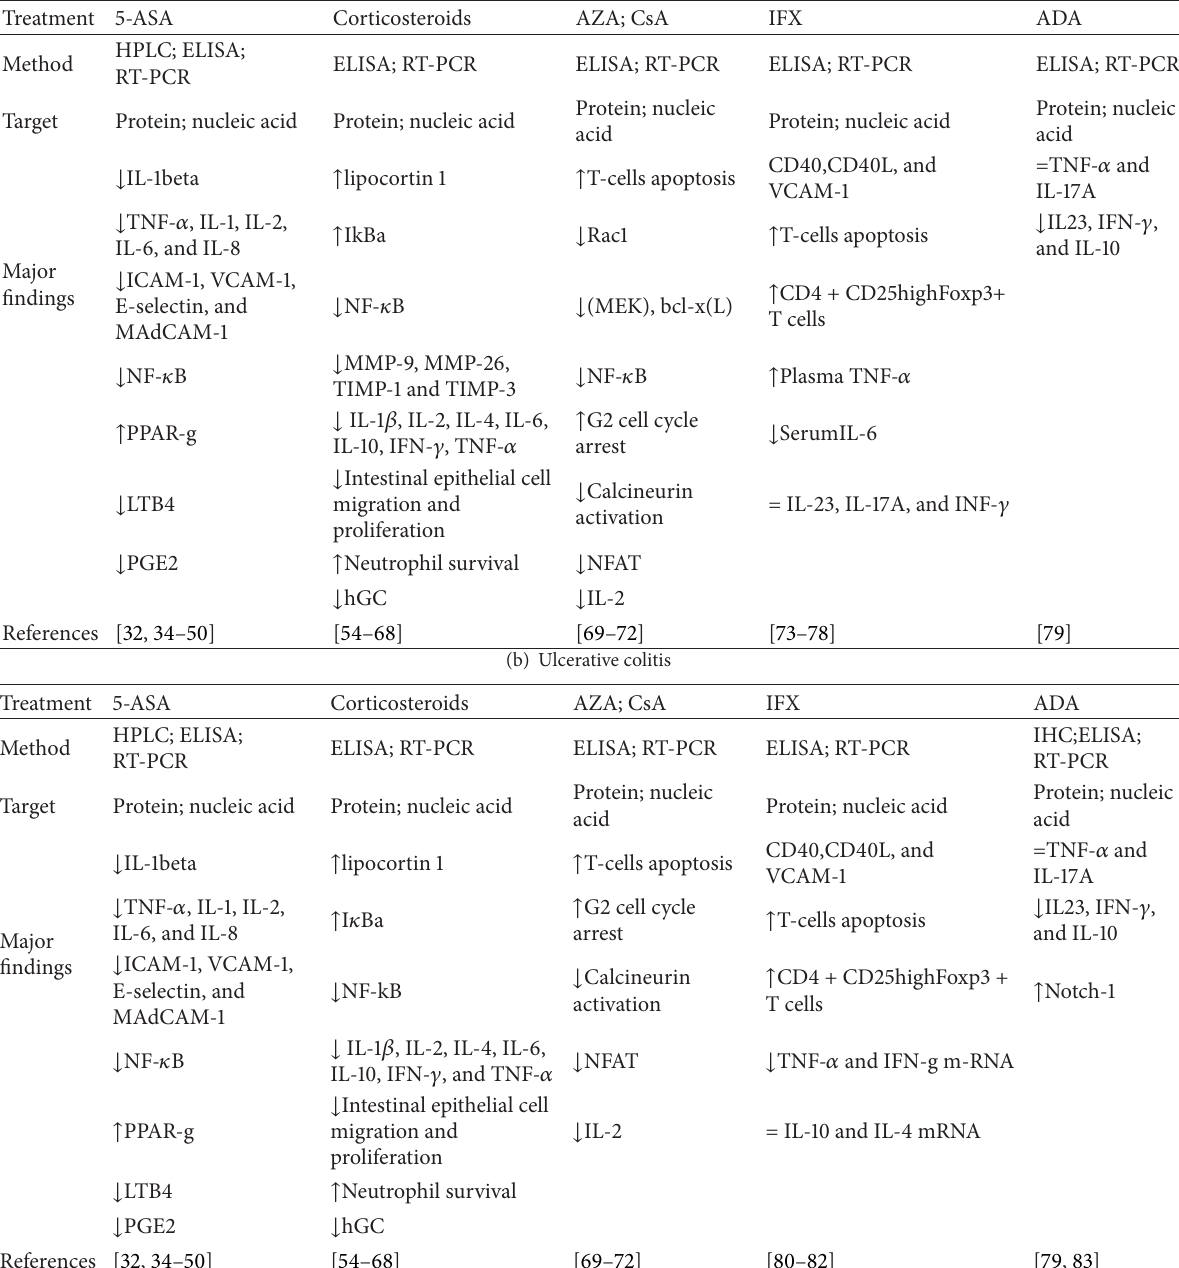
Table 1: Effects of therapeutic strategies in IBD